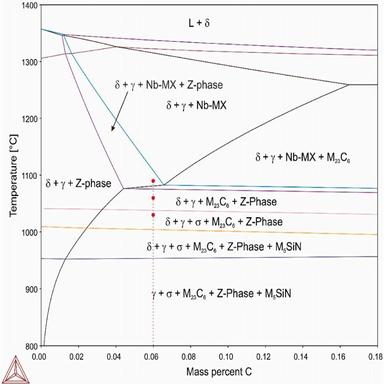
Phase Diagram of SDSS-Nb temperature vs C (wt%), calculated by Thermo-Calc.